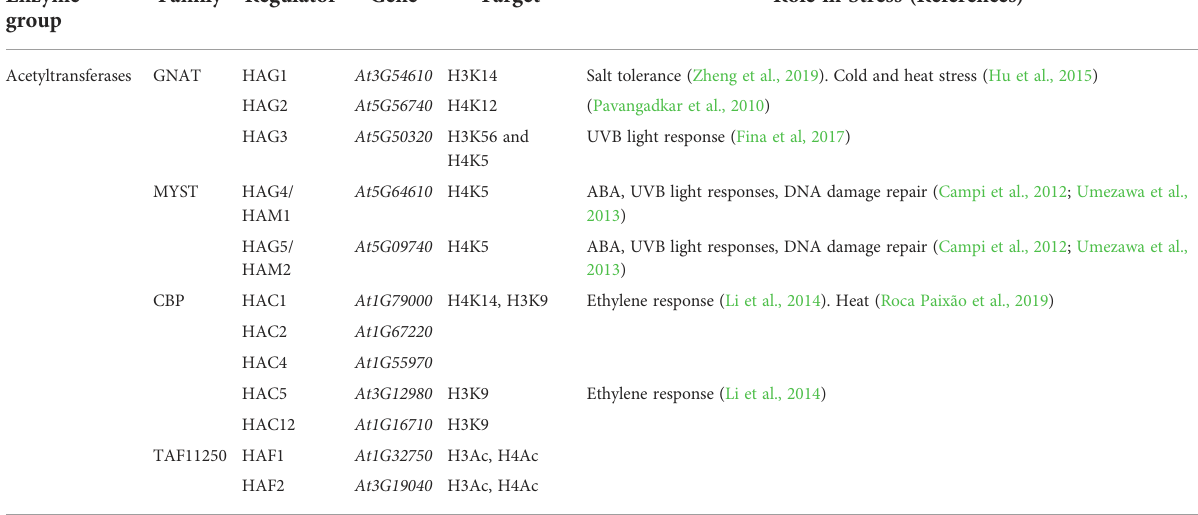
TABLE 2 Classi fi cation of histone acetyltransferases in Arabidopsis . Enzyme Family group